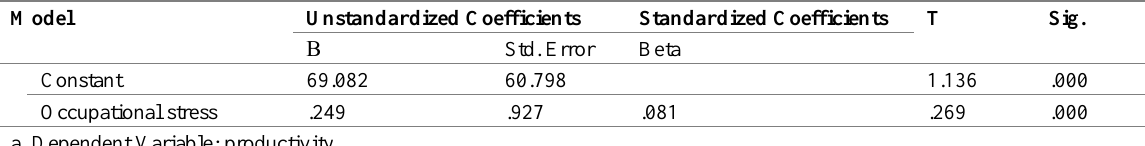
Table 7: Simple Linear Regression: Coefficients a